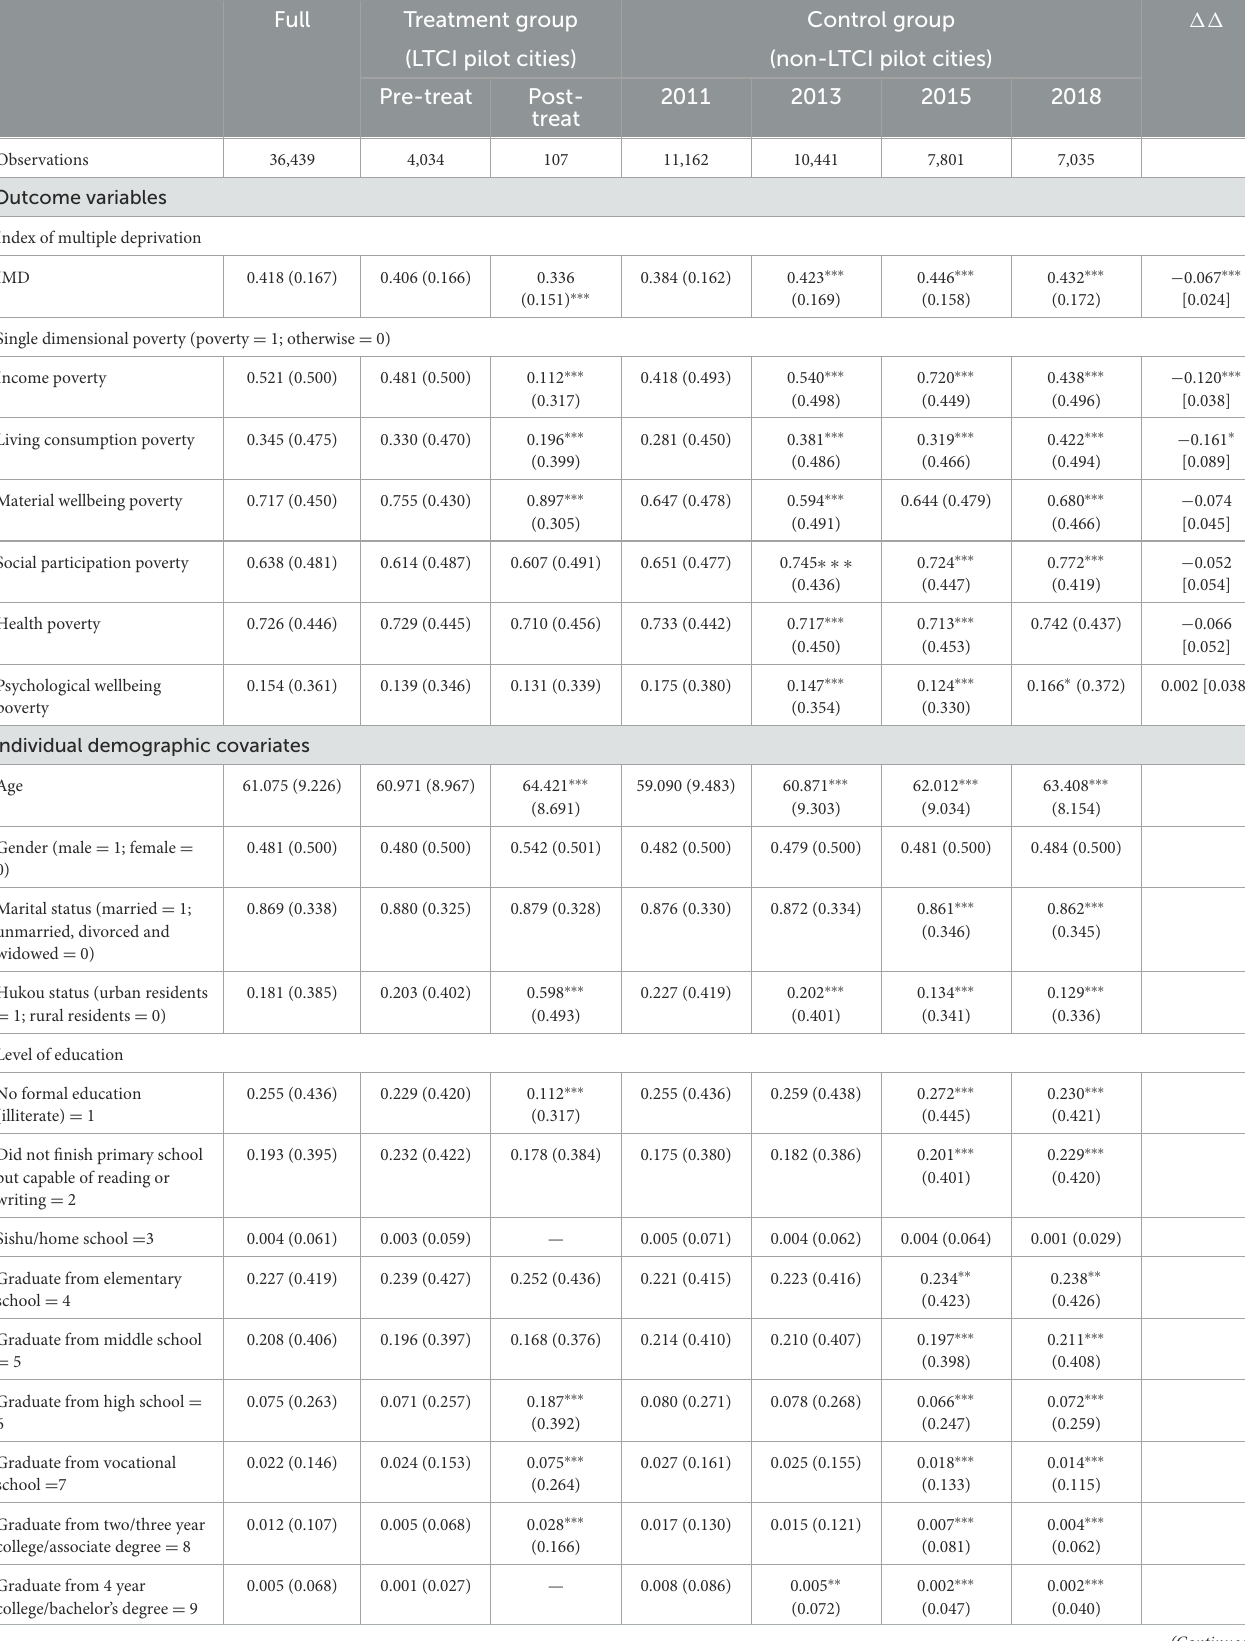
TABLE 2A Summary statistics (2011–2018